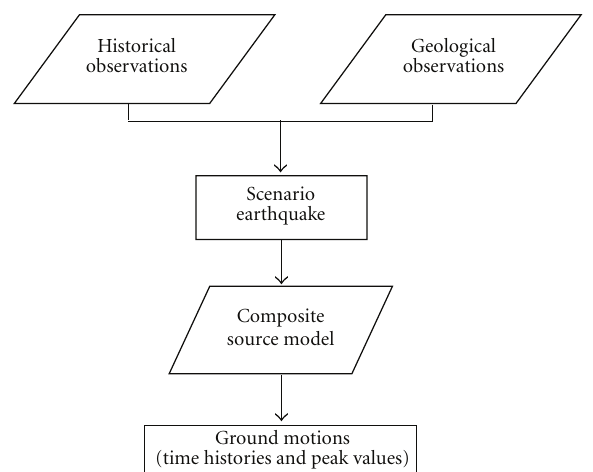
Figure 4: Framework for determining ground motion